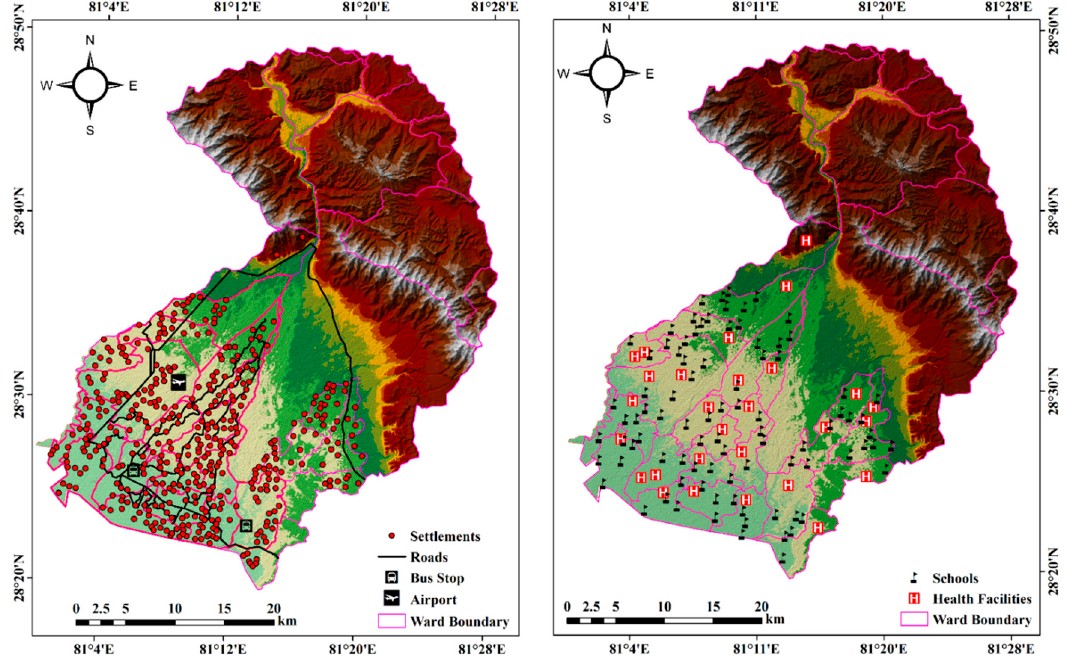
Figure 4. Spatial distribution of physical infrastructures such as roads, airport, bus-terminals and settlements ( left ) and health facilities, schools ( right ) in the study area.